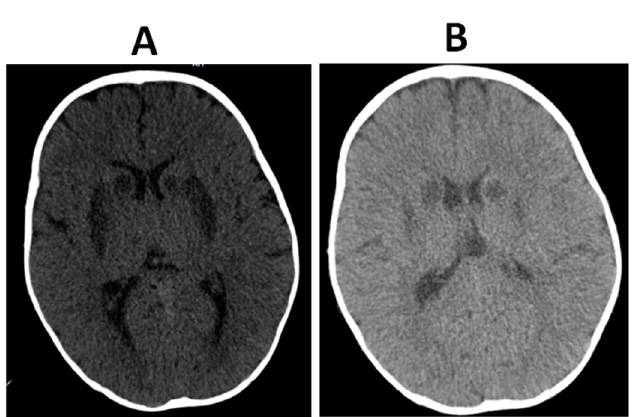
(A) extensive and (B) moderate vascular lesions affecting the basal